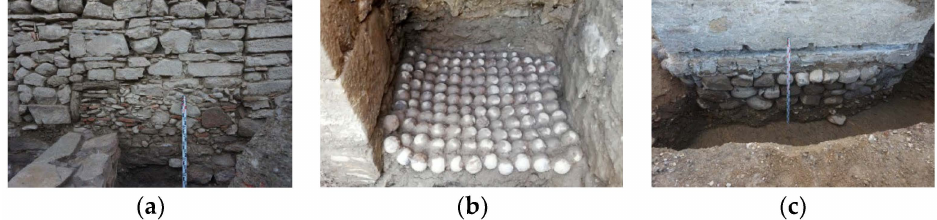
Figure 14. The use of the various stone stack for the construction of the city fortress. ( a ) Sandstone.